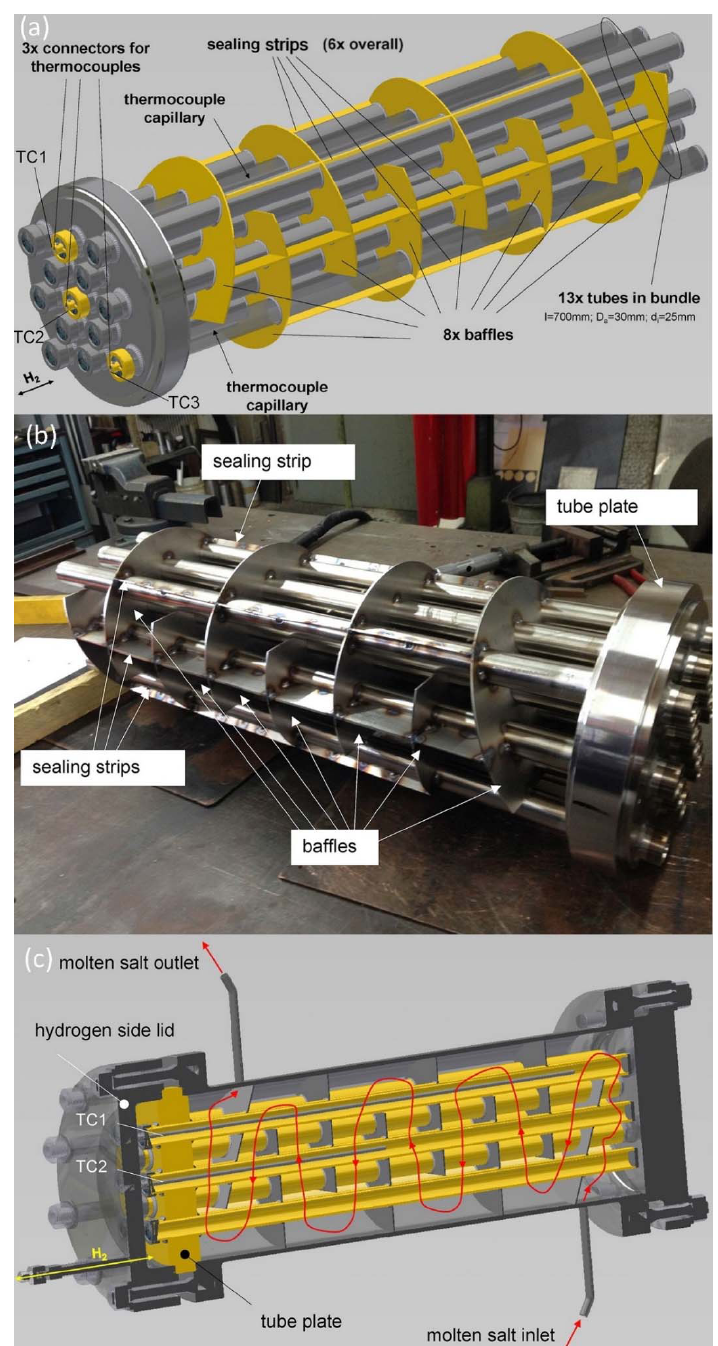
Figure 6. ( a ) Conceptual design of the tube bundle heat storage reactor. ( b ) Tube bundle reactor with welded components. ( c ) Flow of molten salt as directed between the baffles. Reproduced with the permission from [63], Copyright Elsevier, 2017.